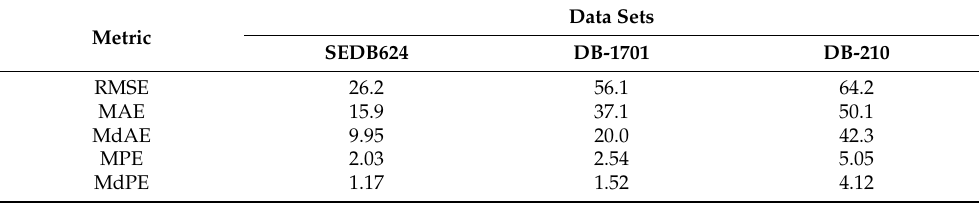
Table 5. The accuracy of retention index prediction for SEDB624, DB-1701, and DB-210 data